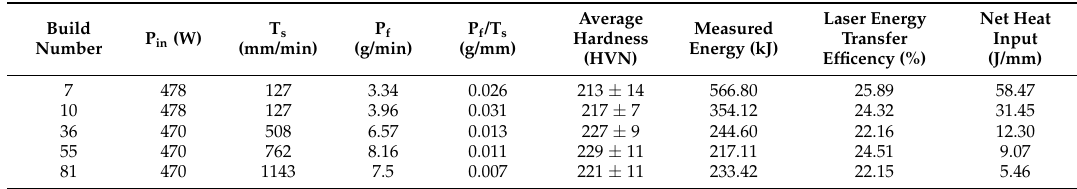
Table 3. Measured parameters of multilayered sample builds.